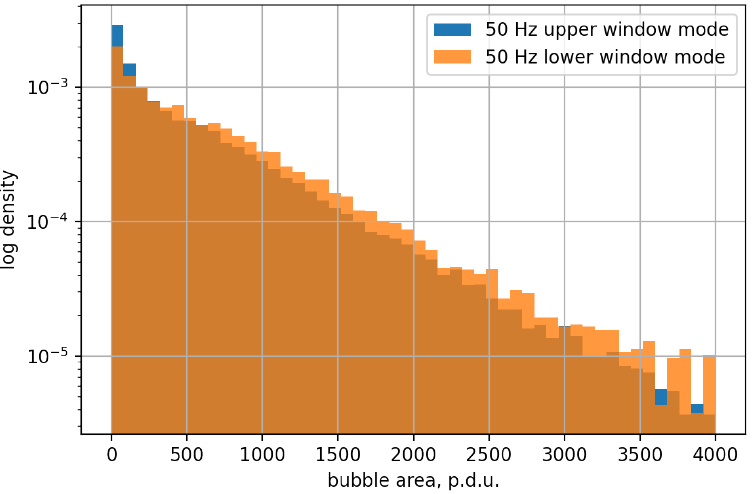
Figure 26. Comparison of logarithmic distributions for F3 vs. F5 videos (filming through upper and lower viewing windows, respectively): the slopes of the distributions seems similar which might indicate that distribution properties remain the same regardless of the window level. However, it might just be a resolution limit similar to the one at 30 Hz (F1 video). Thus, similar to the data represented in Figures 23 and 24, it requires additional